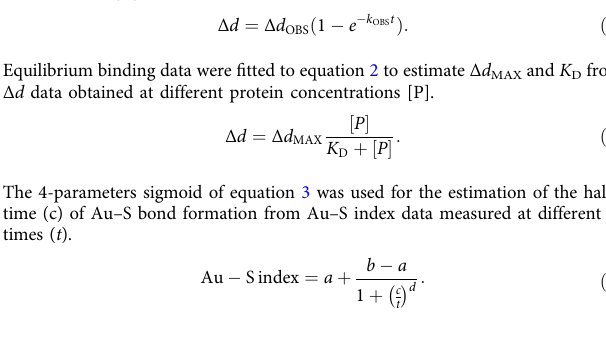
on a 12% pre-cast SDS-PAGE gel (Expedeon) along with a protein ladder (Pre- cision Plus Protein Dual Color Standard, BioRad). The gel was stained for 6h by InstantBlue (Expedeon) and destained in water for 10 h before imaging. Curve fi tting and statistics . All kinetics and equilibrium binding curves were fi tted using a previously described nonlinear least-squares method 70 . The same method was also used to estimate the con fi dence interval of each parameter and the statistical signi fi cance of the differences between them. Kinetics Δ d data acquired at different times ( t ) were fi tted to equation 1 to retrieve observed rate at a determined concentration ( k OBS ) and maximum size increment observed at the same con- centration ( Δ d OBS